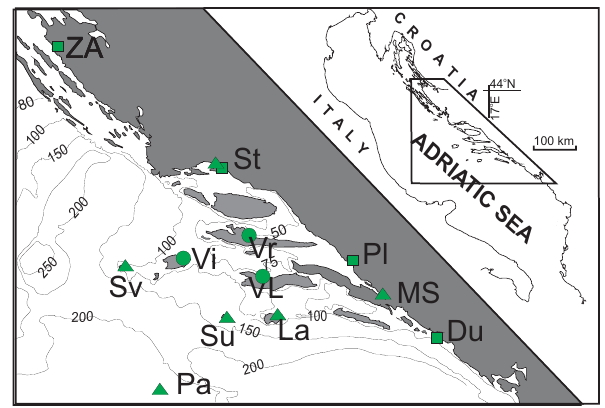
Fig. 1. Bathymetry for the central coastal region Adriatic Sea. Squares mark tide gauge stations: Zadar (Za), Split (St), Ploˇce (Pl), Dubrovnik (Du). Circles mark microbarograph stations: Vrboska (Vr), Vis (Vi) and Vela Luka (VL). Triangles mark possible future microbarograph stations: Svetac (Sv), Suˇsac (Su), Palagruˇza (Pa), Lastovo (La), St and Mali Ston (MS). In the last 30years, strong meteotsunamis have occurred at Stari Grad (near Vr), Vela Luka (VL) and Mali Ston